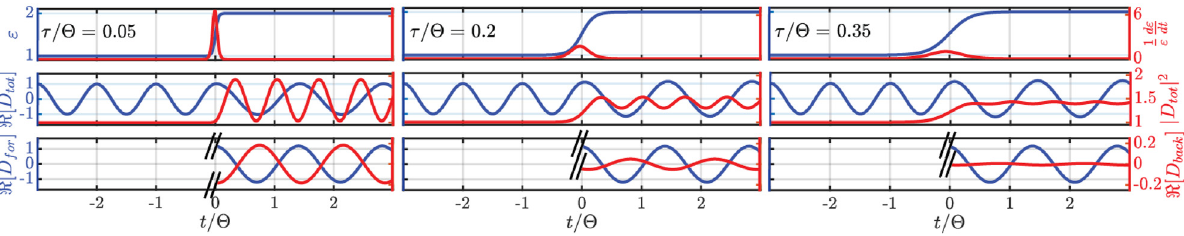
d 𝜀 for a sigmoidal step with rise time 𝜏 ∕Θ = 0.05 (left), 0.2 (center) and 0.35 (right), where 𝜀 d t = 1. Second row: total displacement field R [ D ] and squared 1 tot R R [ T e − i 𝜔 ( t → ∞ ) t ]) and backward (red, [ R e i 𝜔 ( t → ∞ ) t ])